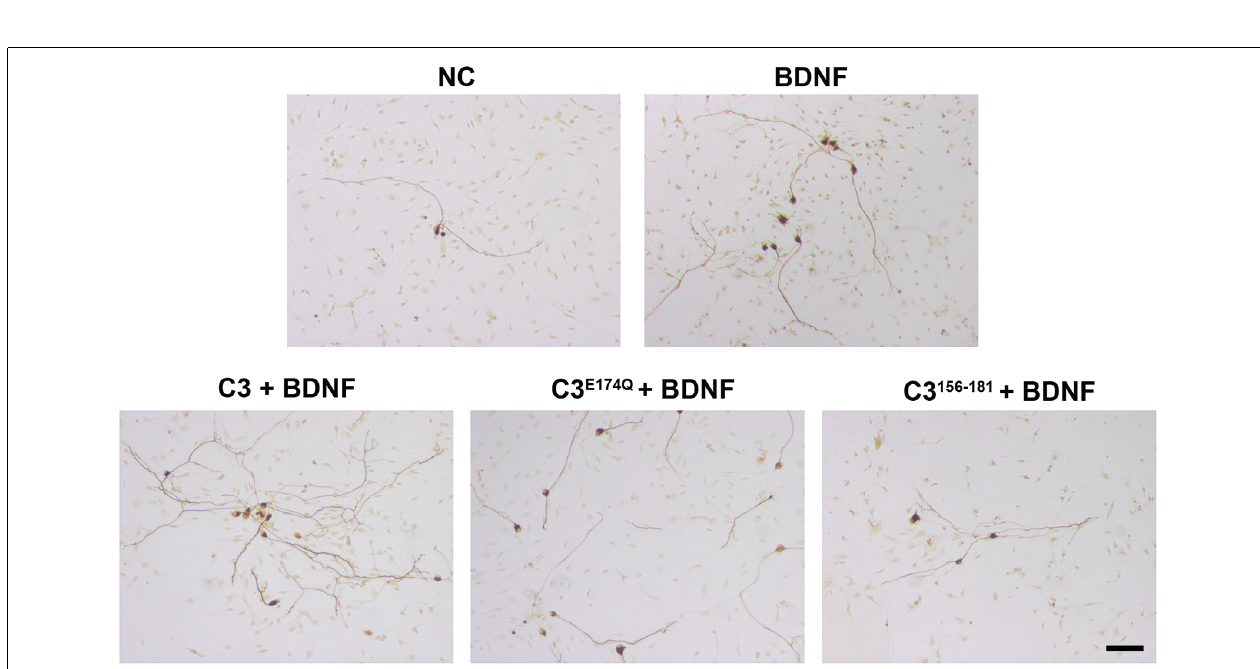
FIGURE 4 | Representative images of SGN treated with various C3 constructs. Cultured SGN were treated with culture medium (NC), BDNF, C3 + BDNF, C3 E174Q + BDNF, and C3 156–181 + BDNF for 48 h and were stained for 200 kDa neurofilament. The combination of all tested C3 constructs and BDNF resulted in more survived SGN when compared to BDNF only or culture medium only. Scale bar, 50 µ